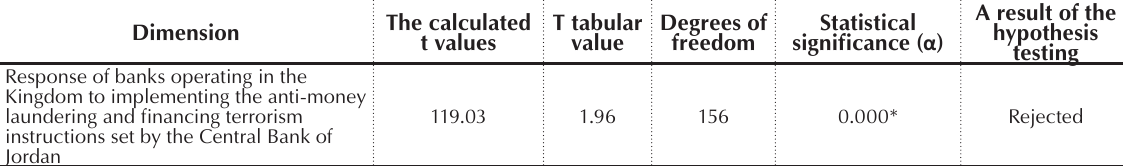
Table (cid:1009). (cid:90)(cid:286)(cid:400)(cid:437)(cid:367)(cid:410)(cid:400)(cid:3)(cid:381)(cid:296)(cid:3)(cid:410)(cid:346)(cid:286)(cid:3)(cid:302)(cid:396)(cid:400)(cid:410)(cid:3)(cid:346)(cid:455)(cid:393)(cid:381)(cid:410)(cid:346)(cid:286)(cid:400)(cid:349)(cid:400)(cid:3)(cid:410)(cid:286)(cid:400)(cid:410)(cid:3)(cid:437)(cid:400)(cid:349)(cid:374)(cid:336)(cid:3)(cid:410)(cid:346)(cid:286)(cid:3)(cid:381)(cid:374)(cid:286)(cid:882)(cid:400)(cid:258)(cid:373)(cid:393)(cid:367)(cid:286)(cid:853)(cid:3)(cid:100)(cid:882)(cid:3)(cid:410)(cid:286)(cid:400)(cid:410) Dimension